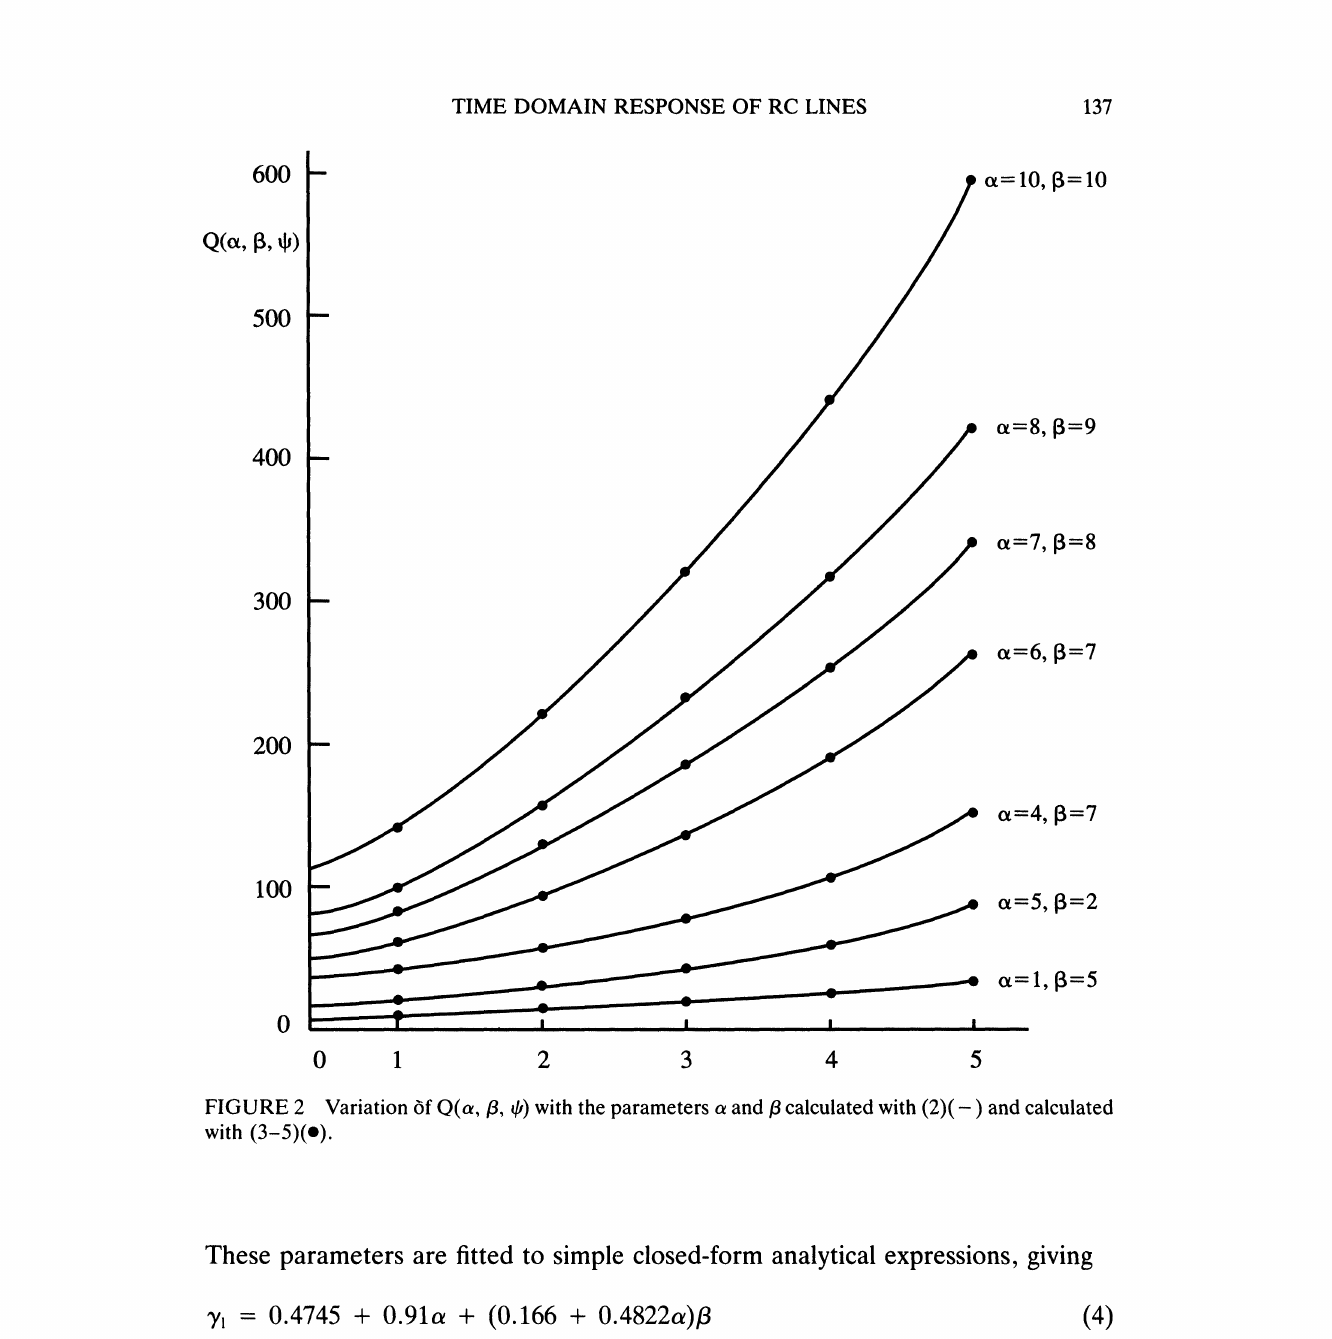
FIGURE 2 Variation 6f Q(a,/3, tO) with the parameters a and/3 calculated with (2)(-) and calculated with